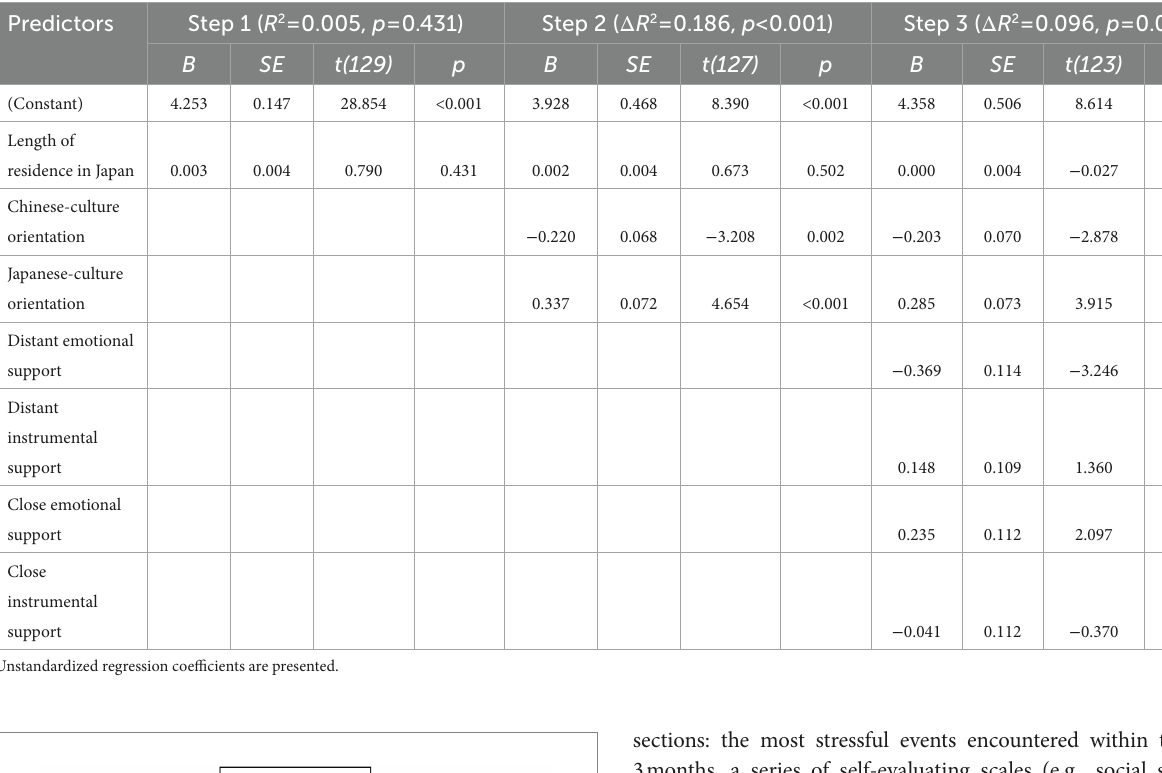
TABLE 2 Results of hierarchical linear regression predicting psychological adaptation in Japan.